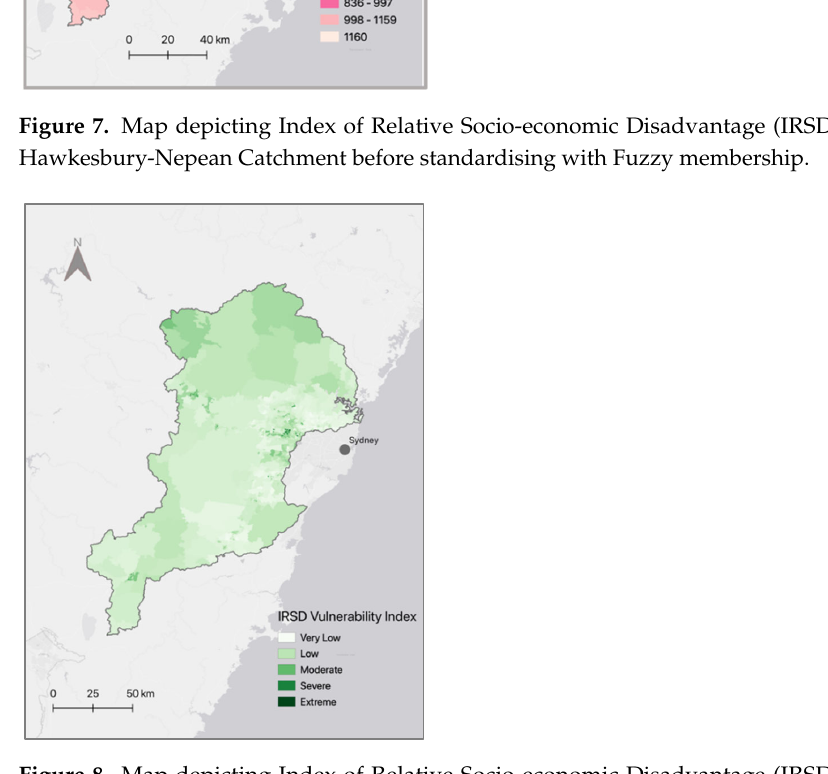
Hawkesbury-Nepean Catchment after standardising with Fuzzy